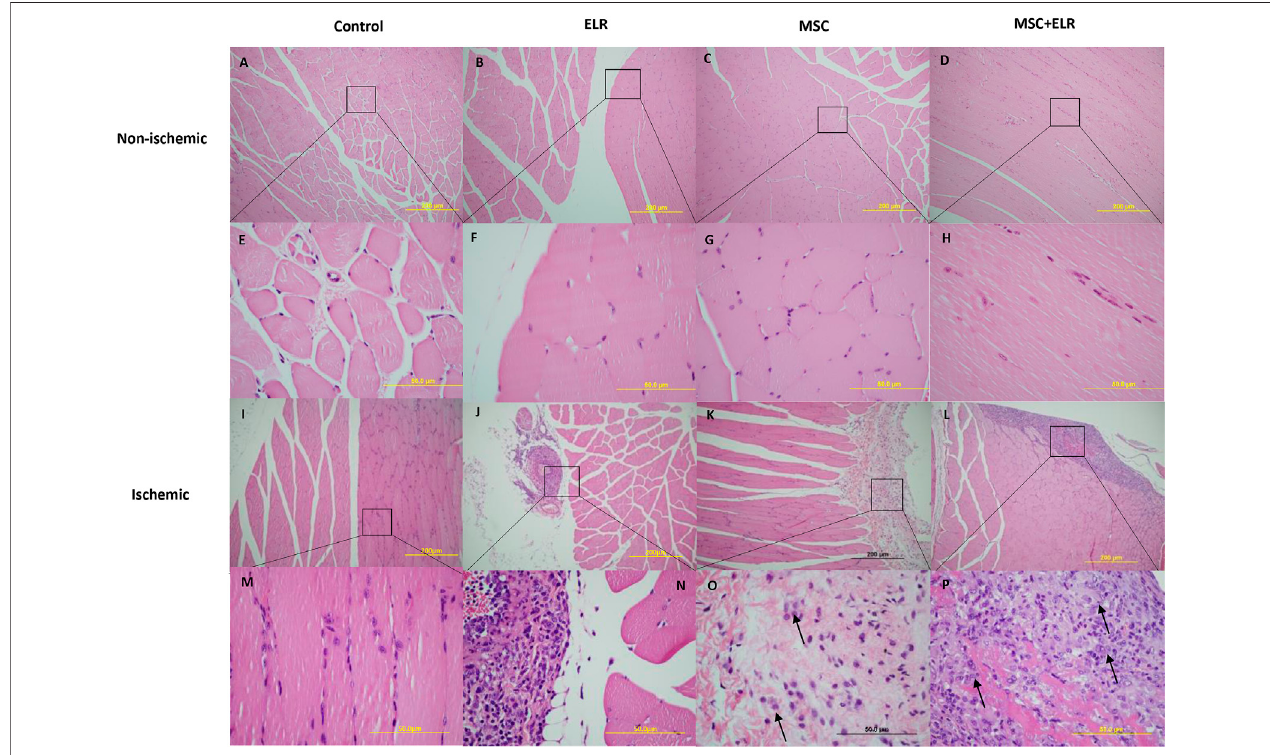
FIGURE2| Morphologyofmuscletissuesections.Representativeimagesofischemicandnon-ischemichindlimbsstainedwithH&Eafter21 dayspostsurgeryare represented. (A – D) and (I – L) 10xampli fi cation. (E – H) and (M – P) 60xampli fi cation.ELR:elastin-likerecombinamer;MSCs:mesenchymalstromalcells.Arrowspointout